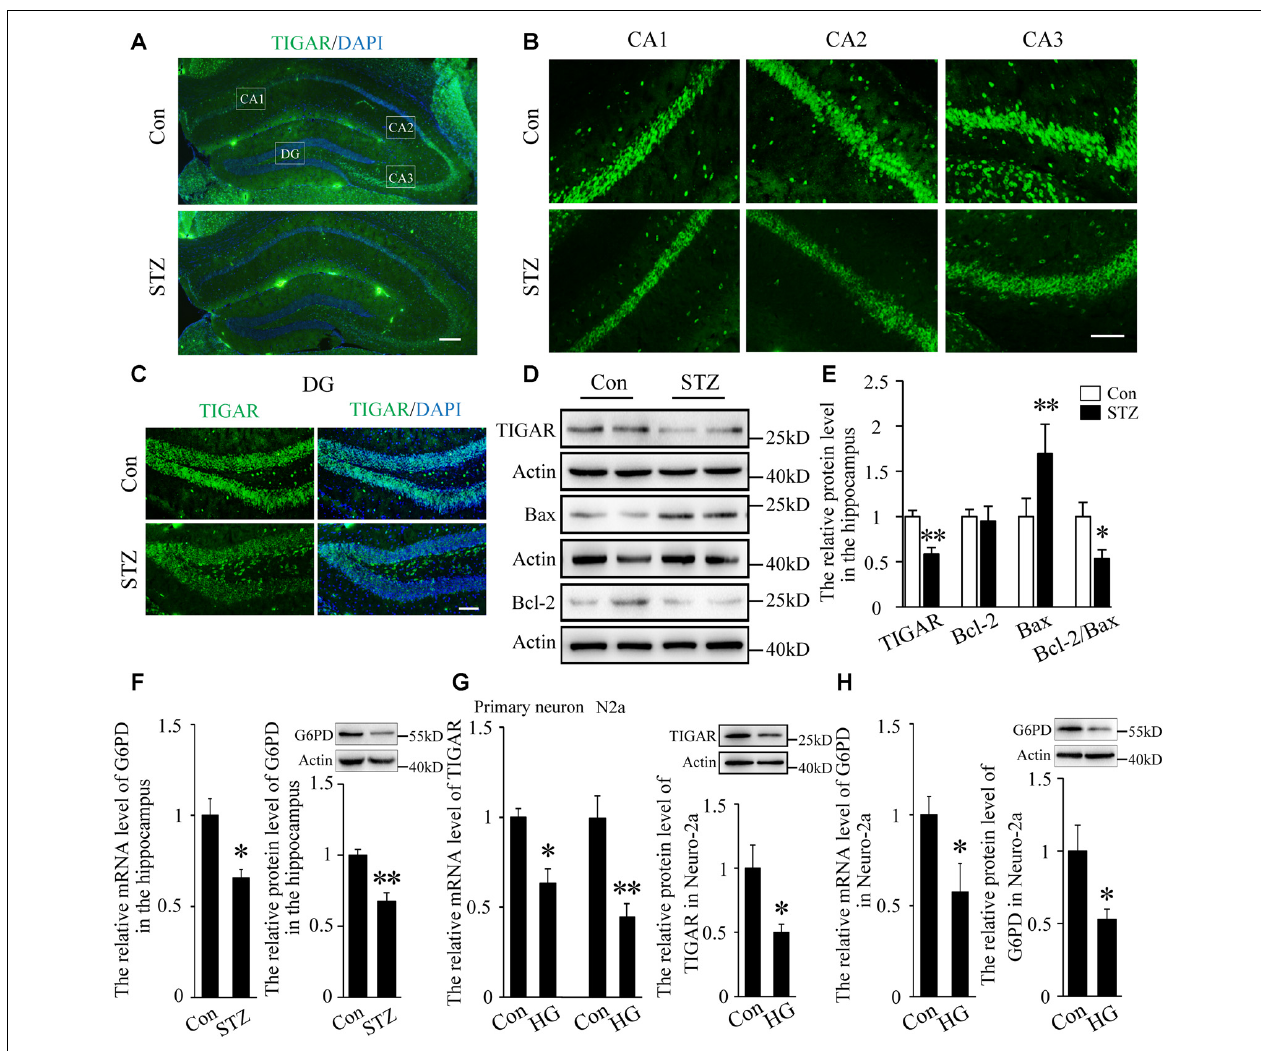
FIGURE 1 | TP53-inducible glycolysis and apoptosis regulator (TIGAR) expression in the hippocampus of streptozotocin (STZ)-induced diabetic mice. (A) Immunofluorescent staining of TIGAR expression in the hippocampus in control group and STZ-treated group. Scale bar = 200 µ m. (B,C) The expression of TIGAR in the CA1, CA2, CA3 and dentate gyrus (DG) of the hippocampus. Scale bar = 50 µ m. (D,E) Western blot analysis of TIGAR, Bcl-2 and Bax in the hippocampus of each group ( n = 6 per group). (F) Quantification of the mRNA and protein levels of glucose 6-phosphate dehydrogenase (G6PD) in each group ( n = 4 per group). (G) Quantification of the mRNA and protein levels of TIGAR in high glucose-treated hippocampal primary neurons and Neuro-2a cells ( n = 3–6 per group). (H) Quantification of the mRNA and protein levels of G6PD in high glucose-treated Neuro-2a cells ( n = 3–4 per group). ∗ p < 0.05, ∗∗ p < 0.01, t -test. Data represent the mean of at least three independent